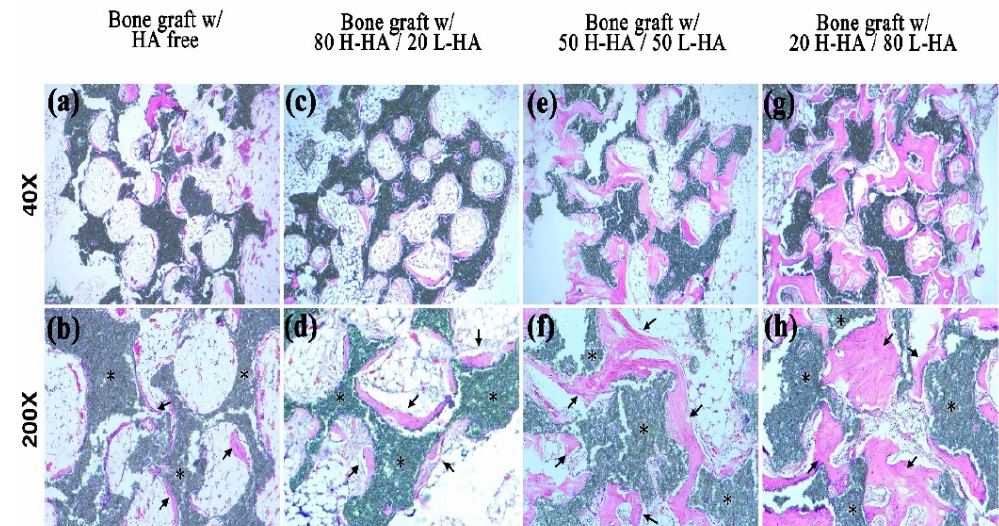
Figure 6. Histological images of tissue sections at artificial defects in rabbit femoral condyles. Microscopy images of bone graft with HA free ( a , b ), bone graft with 80 H-HA/20 L-HA ( c , d ), bone graft with 50 H-HA/50 L-HA ( e , f ) and bone graft with 20 H-HA/80 L-HA groups ( g , h ). The symbol * denotes the residual bone graft. Black arrows indicate newly formed bone. (upper panel: 40 × ; lower panel: 200 × ). Quantification of histological images showed new bone formation in bone defects treated with 50 H-HA/50 LHA and 80 H-HA/20 L-HA hybrid complexes at 31.21 ± 4.72% and 42.00 ± 4.72%, respectively. These values are significantly higher ( p < 0.05)